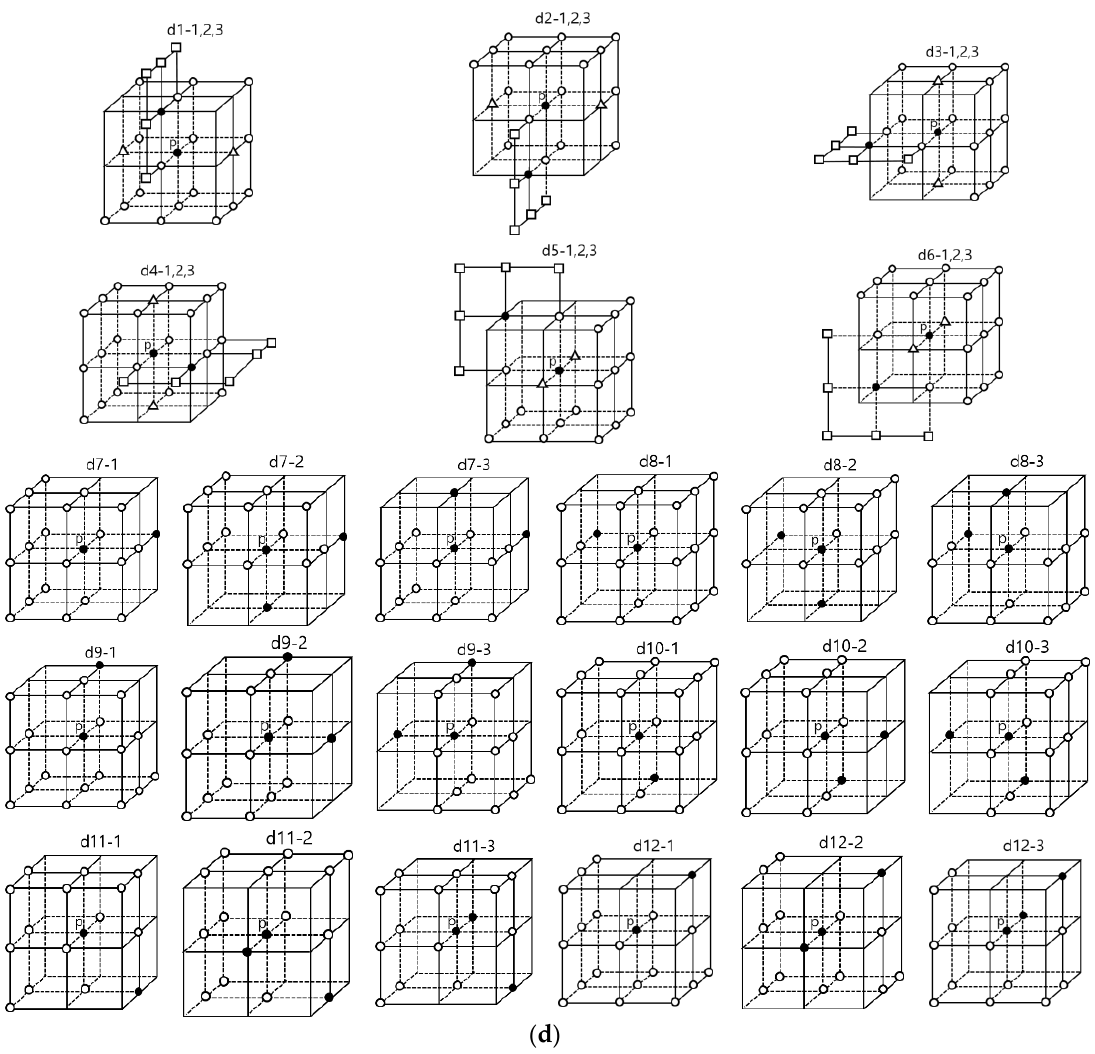
Figure 3. 62 pre-defined removing templates of classes A, B, C, and D. ( a ) 6 removing templates in class A; ( b ) 12 removing templates in class B; ( c ) 8 removing templates in class C; ( d ) 36 removing templates in class D.